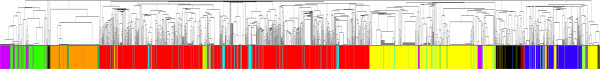
Hierarchical clustering of all yeast proteins using distance based on the MFscore. The color bar below the dendogram uses the same color scheme as Figure 6A to indicate the molecular function annotation of the proteins. The dendogram closely resembles the MDS of the yeast proteins. Five clusters can be seen in the dendogram: "catalytic activity" in red, "binding" in pink, "transcription regulator activity" in light green, "structural molecule activity" in orange, and "transporter activity" in dark blue. The dendogram was produced with the JavaTreeView software .